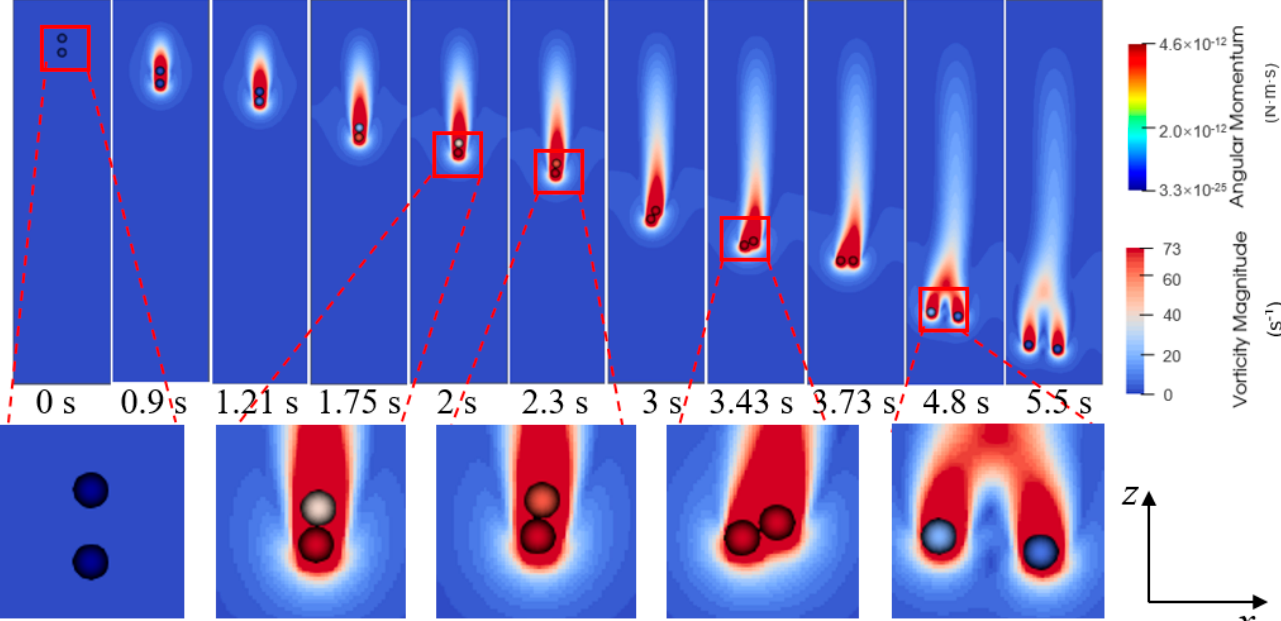
Figure 5. Distribution of the magnitudes of fluid vorticity and particle angular momentum in the sedimentation process of two in-tandem particles with terminal Re = 18.18.